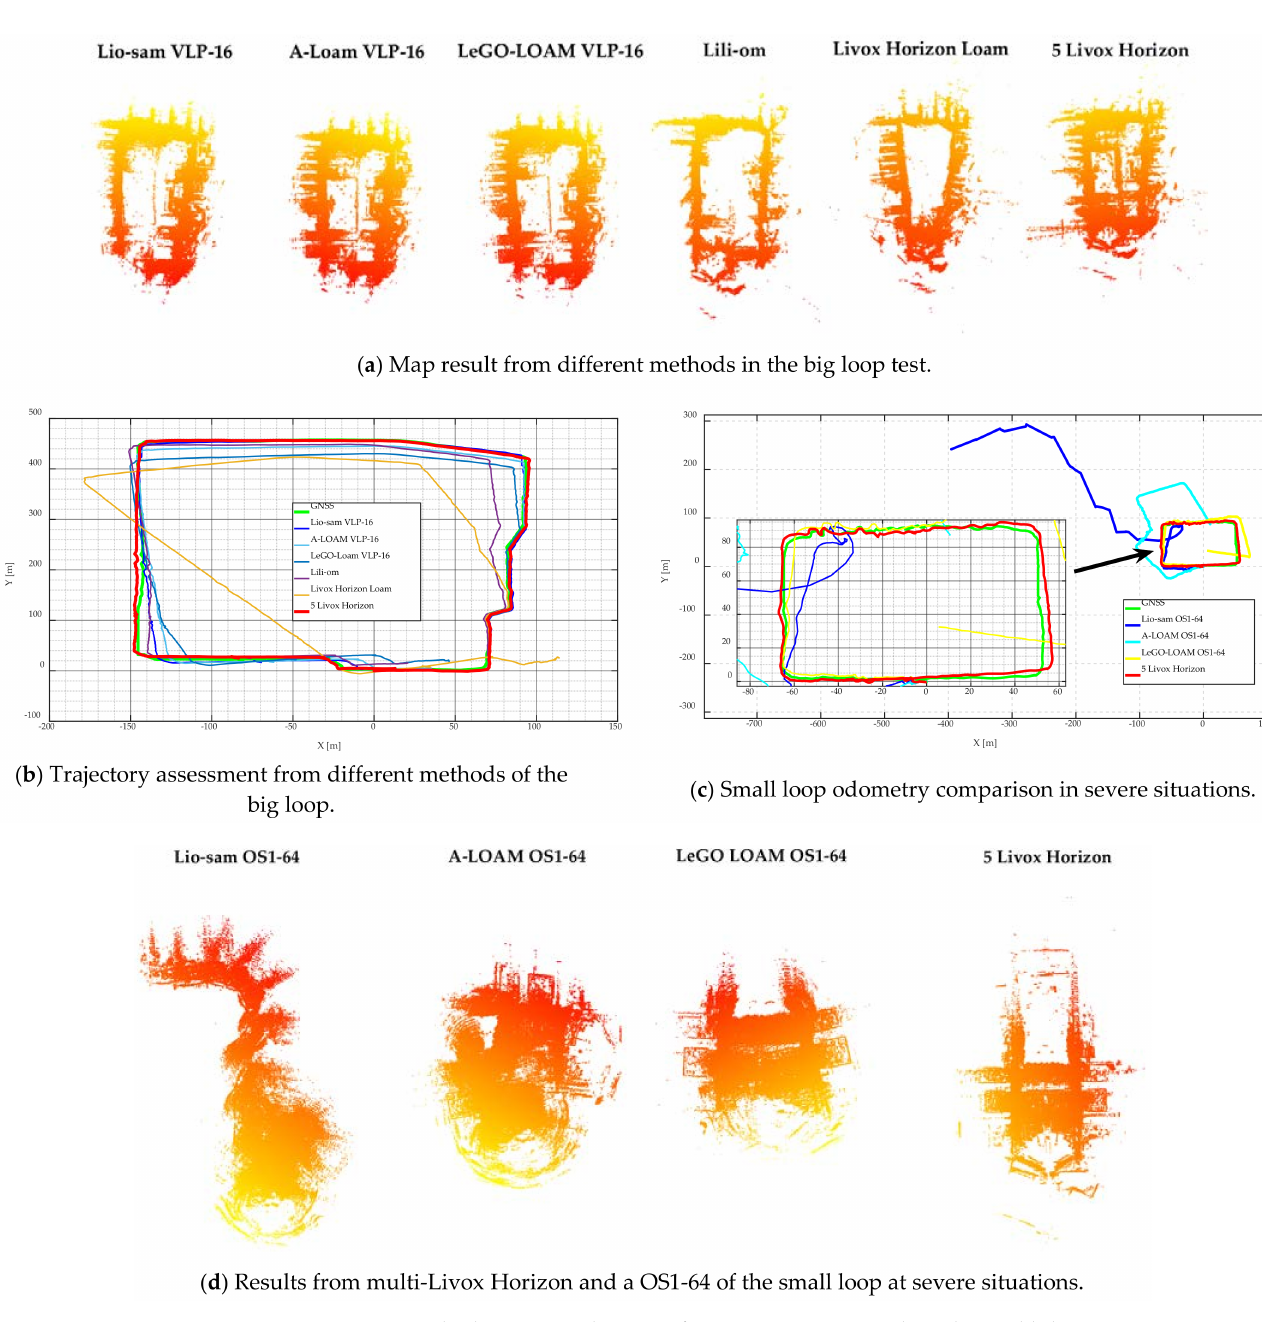
Figure 15. Mapping and odometry evaluation of 5 Livox Horizons and mechanical